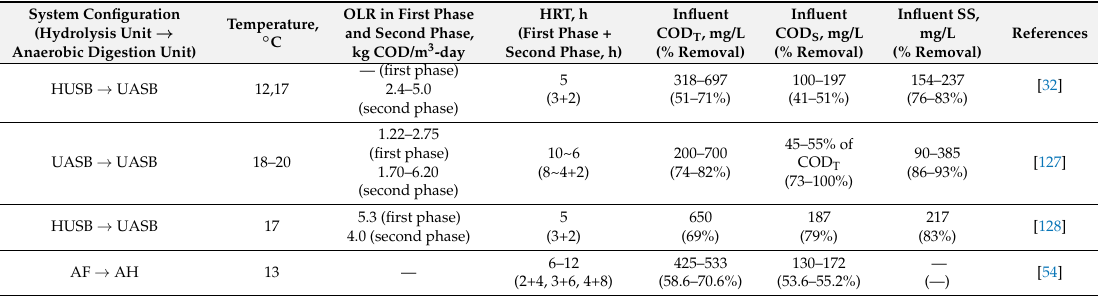
Table 6. Overall domestic sewage treatment performances in two-phase hydrolysis-UASB processes. System Configuration (Hydrolysis Unit